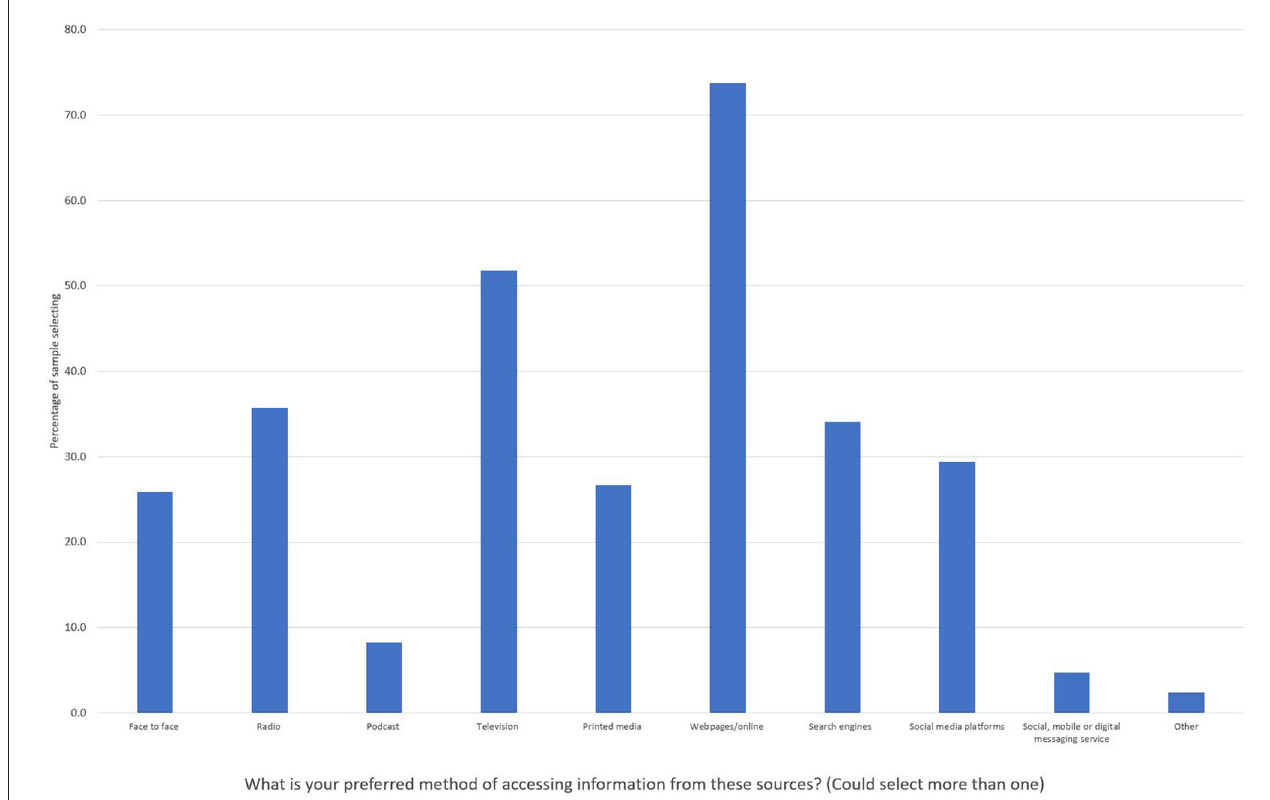
FIGURE2 Percentage of method of access (vs. not) for different sources of information ( n =